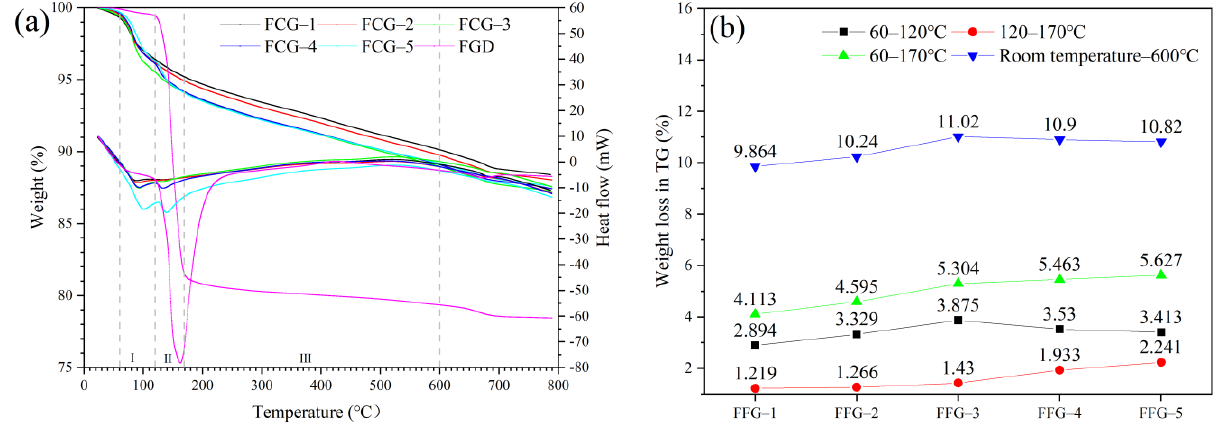
Figure 9. (a) TG and heat flow of bricks at 28 days; (b) the weight loss of TG at different stages. Figure 9. ( a ) TG and heat flow of bricks at 28 days; ( b ) the weight loss of TG at different stages.